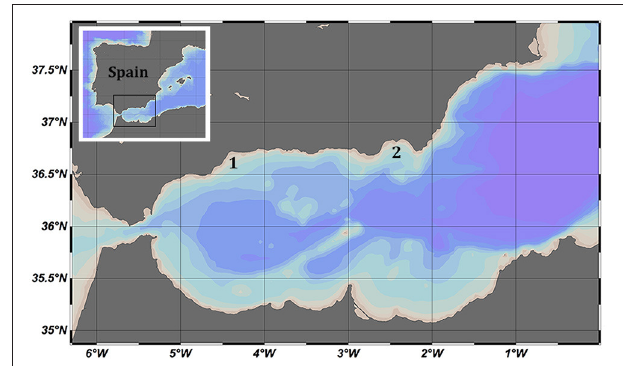
FIGURE 1 | Fish farms locations in the Spanish coast of the Alboran Sea: (1) Málaga Bay and (2) Almería Gulf.